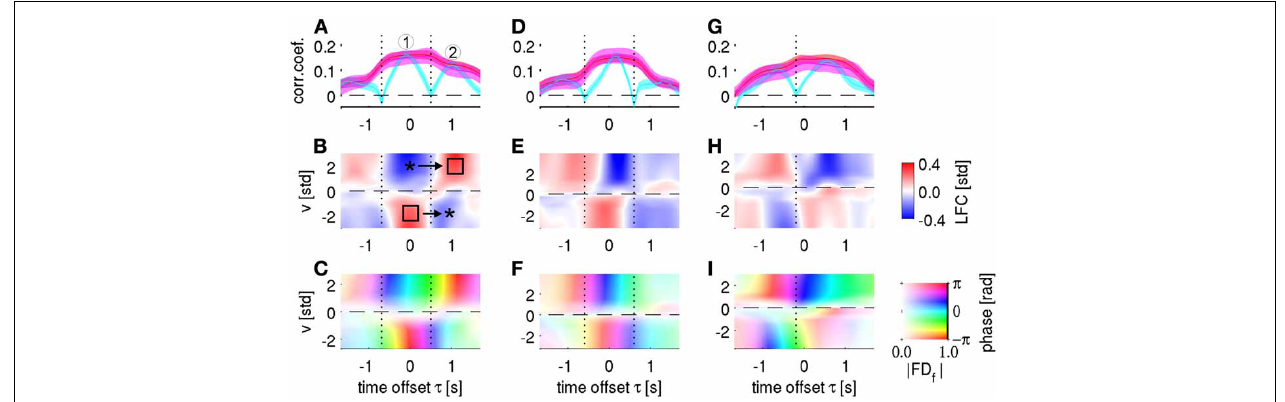
FIGURE 10 | Single channel velocity decoding and tuning analysis. Columns represent the three selected channels from subjects S1–S3, respectively. (A) Single-channel decoding accuracy at different time offset τ (same notation as in Figure 5A ). The three different features analyzed are: time-frequency magnitude and phase (red), time-frequency phase-only (magenta), and time-domain LFC (cyan). The selected channel corresponds to 1st row and 3rd column in the ECoG grid of subject S1 (cf., Figure 2 ). Note the “camel back” shape of the LFC-based decoding with two separate peaks indicated by “1” and “2.” (B) Velocity—ECoG LFC tuning. The x -axis defines the time offset τ between velocity and ECoG data, the y -axis defines the velocity bins v (where v > 0 for rightward movements and v < 0 for leftward movements). The binned ECoG LFC average is color-coded (and interpolated). Around τ = 0s, a polarity gradient of mean LFC from positive (for v < 0) to negative (for v > 0) can be observed (left star and square, respectively). Approximately 1s later, the polarity was